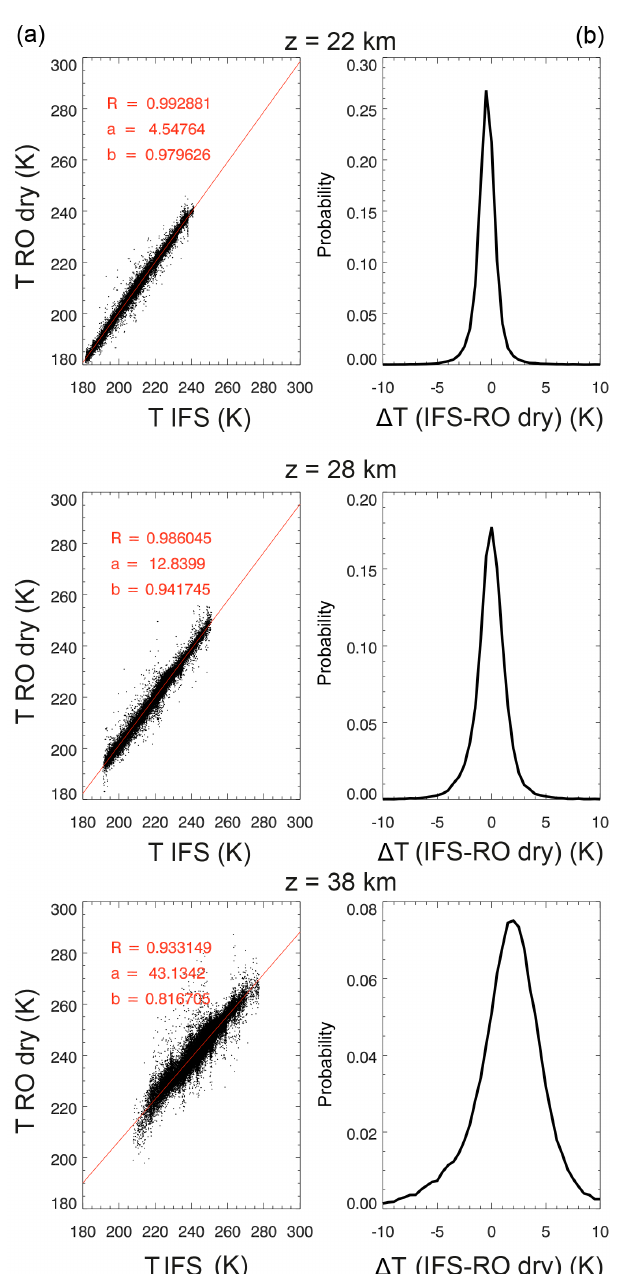
Figure 3. Scatter plots (a) between RO-dry temperatures and cor- responding IFS data for 30 months of data between July 2014 and December 2016 for three selected altitudes. The red line shows a linear fit to the data with slope b, y intercept a, and correlation co- efficient R (see insert). Panel (b) shows histograms of the corre- sponding temperature differences between IFS and RO-dry data for the same selected altitudes.